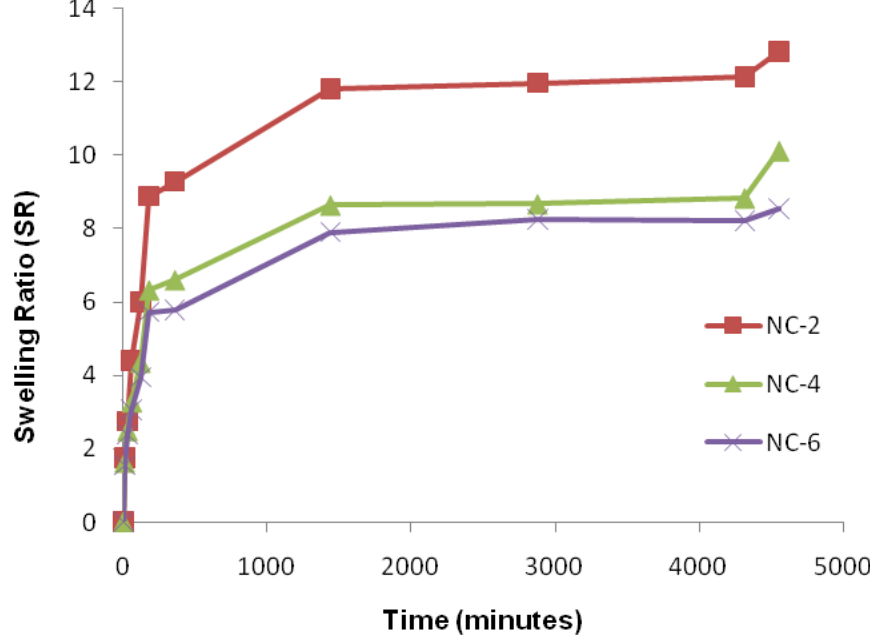
Figure 11. Effect of cloisite 30B content of NCHs on SR in phosphate ‐ buffered saline, pH 7.4. Figure 11. E ff ect of cloisite 30B content of NCHs on SR in phosphate-bu ff ered saline, pH